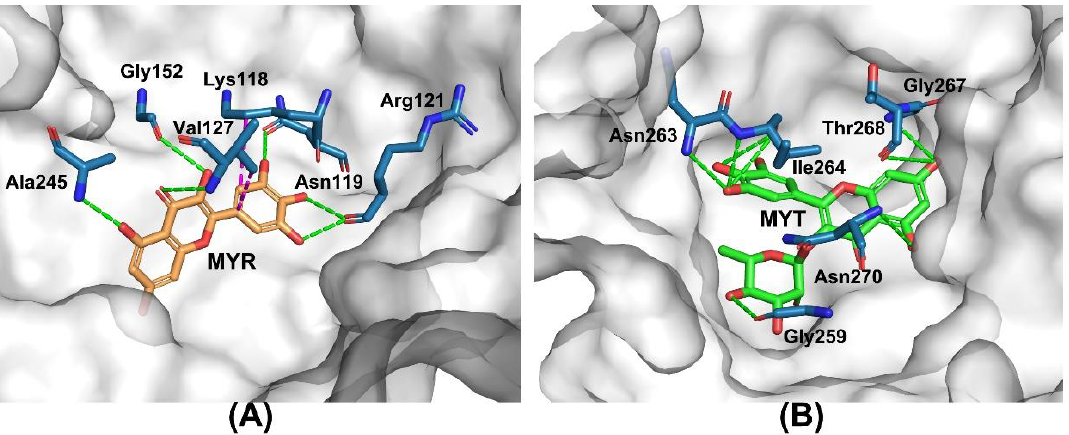
Figure 7 . The lowest binding energy poses for PK-MYR ( A ) and PK-MYT ( B ) in the 3D-view cartoon presentation. Green dashes indicate hydrogen binding, and purple dashes indicate hydrophobic interactions between the host and the ligand.